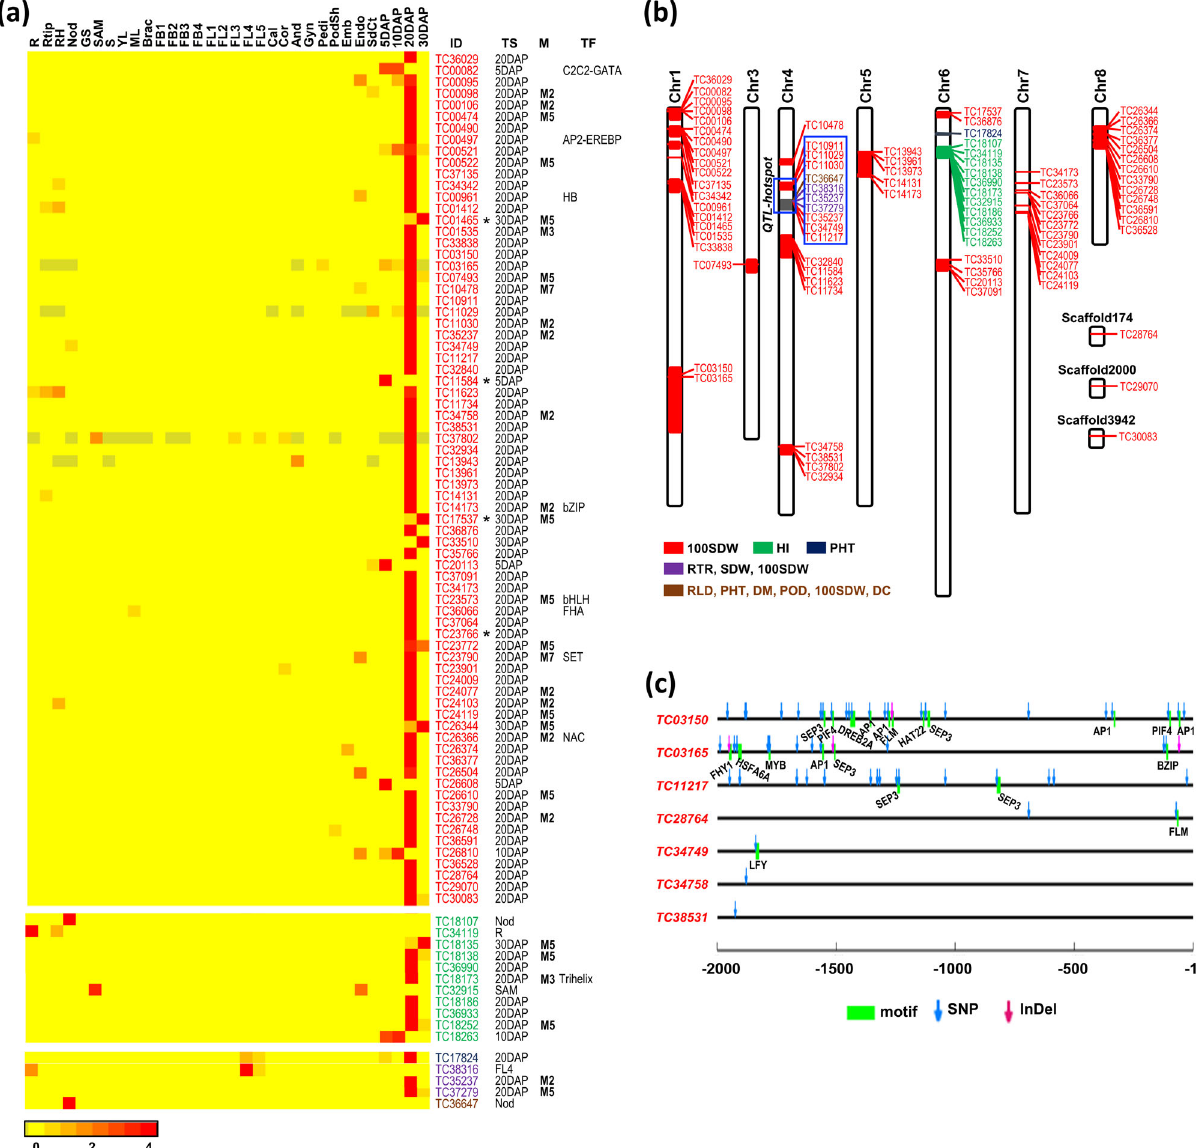
Fig. 7 Candidate transcripts exhibiting tissue-speci fi c expression associated with quantitative trait loci (QTLs). a Heatmaps illustrate the tissue-speci fi c expression of the candidate genes located within 100 seed weight (100 SDW) and other traits (HI, PHT, RTR, SDW, RLD, DM, POD, and/or DC) associated QTLs. The identi fi ers of the transcripts located on the QTLs of different traits are shown in different colors. The transcripts representing lncRNAs are marked with asterisks. The tissue speci fi city (TS) of each transcript is also indicated. Transcription factor family annotation (TF) and coexpression module (M), if any, of the transcripts are also given. The color scale at the bottom represents the expression level in Z -score. b Ideogram showing the genomic location of the candidate genes in the quantitative trait loci (QTLs; solid colored boxes) on the chickpea genome (vertical bars). QTLs/candidate genes for different traits are shown in different colored boxes/fonts as shown in the legend. The position of QTL-hotspot on chromosome 4 and the candidate genes lying within this region are marked with blue colored boxes. c The DNA polymorphisms (SNPs and Indels) differentiating small- and large-seeded chickpea genotypes that are located in the promoter (2 kb upstream) regions of the transcripts are shown. The cis -regulatory elements harboring the DNA polymorphisms are also